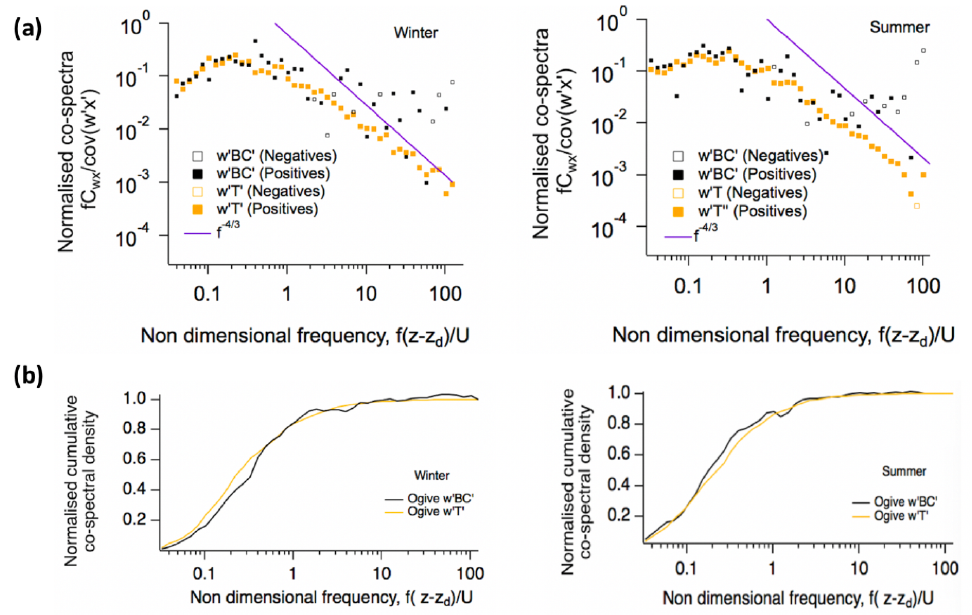
Figure 3. (a) Median of BC flux (black) and temperature (sensible heat) (yellow) co-spectrum multiplied by natural frequency ( f ) and normalised using total covariance against non-dimensional frequency. Data are binned into 44 logarithmically evenly spaced bins, and co- spectra with total BC flux > 0ng − 2 s − 1 and carefully selected frictional velocity for more turbulent periods (see Sect. 3.2) were chosen for median averaging. A total of 223 (winter) and 170 (summer) cases are averaged. (b) Normalised cumulative co-spectra of BC flux and sensible heat